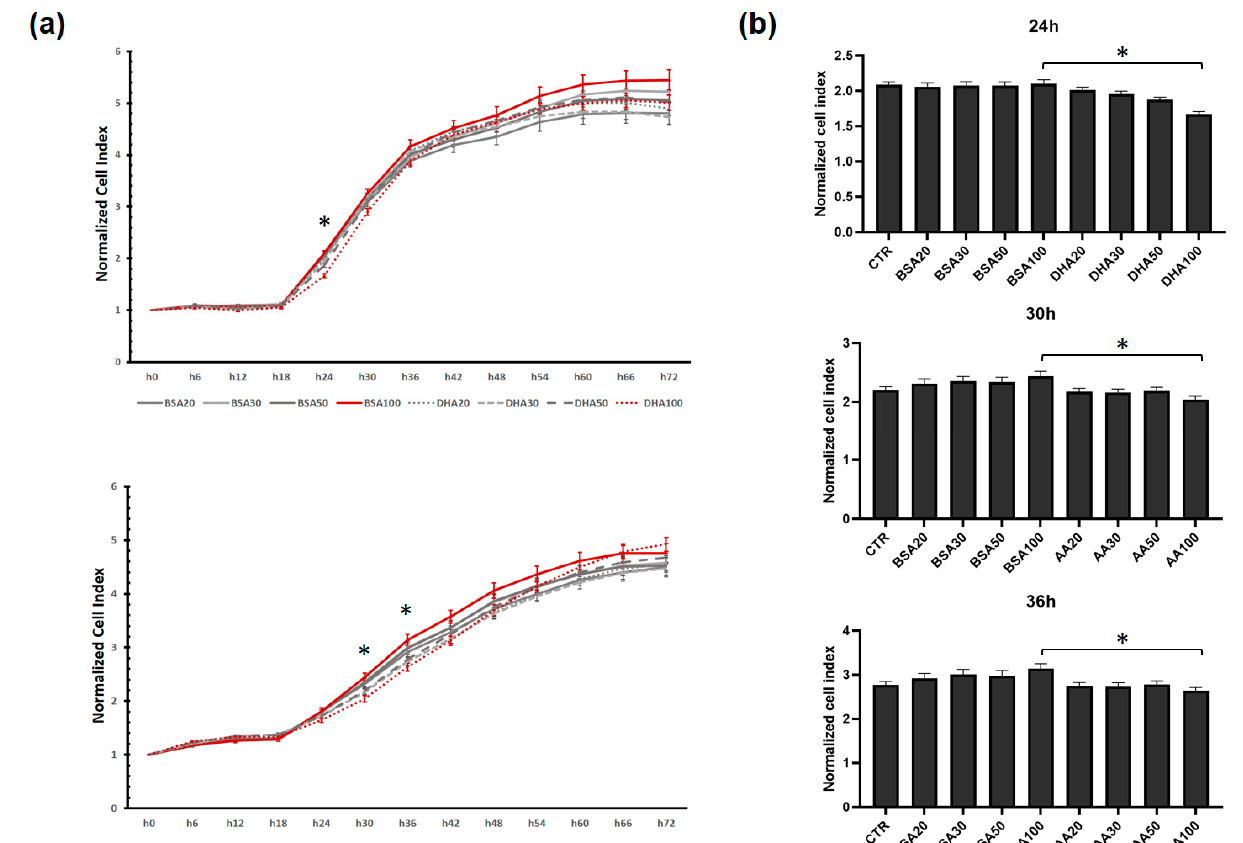
Figure 2. The effect of PUFA treatment on C2C12 cell proliferation. The changes were observed in real-time with the xCELLigence system after DHA and AA treatments. ( a ) The normalized cell index for all treatments is shown with dot lines (DHA or AA) and the respective BSA control for each group with solid lines. The cells were exposed to 20, 30, 50 and 100 μ M of DHA or AA. The red solid line represents the concentration of BSA100 and the red dot line represents the concentration of DHA100 or AA100. ( b ) Monitoring living cells showed three time points when PUFA treatments at high doses reduced C2C12 proliferation. After 24 h, the cell index showed a decrease with DHA100 (100 μ M) but no changes in DHA20, DHA30 or DHA50. After 30 and 36 h, the cell index showed a significant decrease with AA100 but no changes were observed in AA20, AA30 or AA50 treatments. Error bars indicate standard error of the mean (SEM), the asterisk * indicate significance between PUFA and equivalent BSA control at p < 0.05. The scale of the Y-axis corresponds to the normalized cell index of ( a ) with the same time point. CTR refers to control, i.e., GM without AA or DHA or BSA.